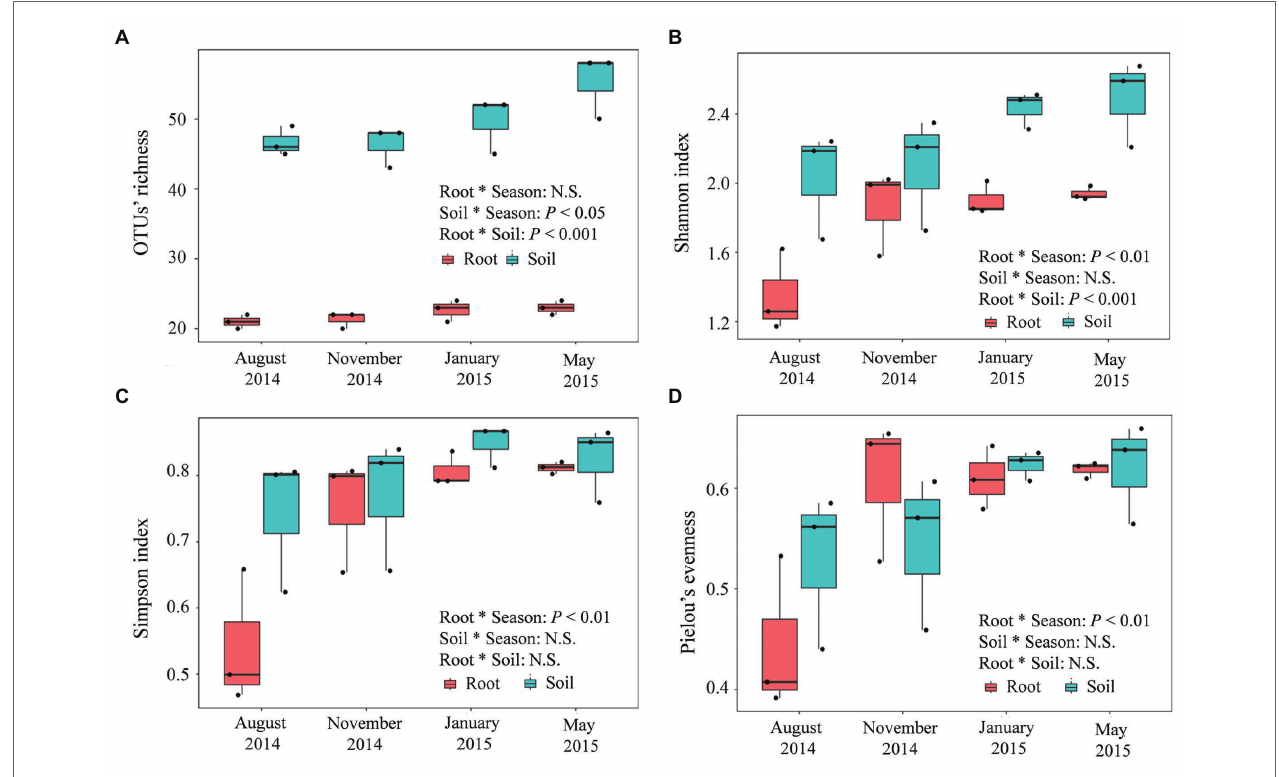
FIGURE 6 | Seasonal changes in the alpha-diversities of the root-associated and rhizospheric soil fungal communities in P. tabuliformis forests located in the Qinling Mountains. (A) OTU richness, (B) Shannon, (C) Simpson, and (D) Pielou’s evenness. The horizontal bars within boxes represent the median. The tops and bottoms of boxes represent the 75th and 25th quartiles, respectively. The upper and lower whiskers extend 1.5× the interquartile range from the upper edge and lower edge of the box, respectively. N.S.,